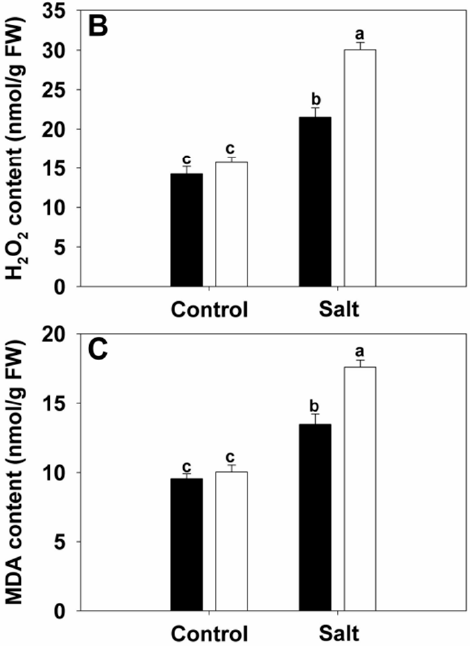
Figure 3. ROS accumulation in response to salinity stress in ss3 mutant compared with WT. Growth conditions and treatments were the same as described in Figure 1. The AsA content ( A ), H 2 O 2 content ( B ), and MDA content ( C ) are shown. The values are means ± SE of five replicates. Significant differences at p < 0.05 are indicated with different letters. FW—fresh weight.